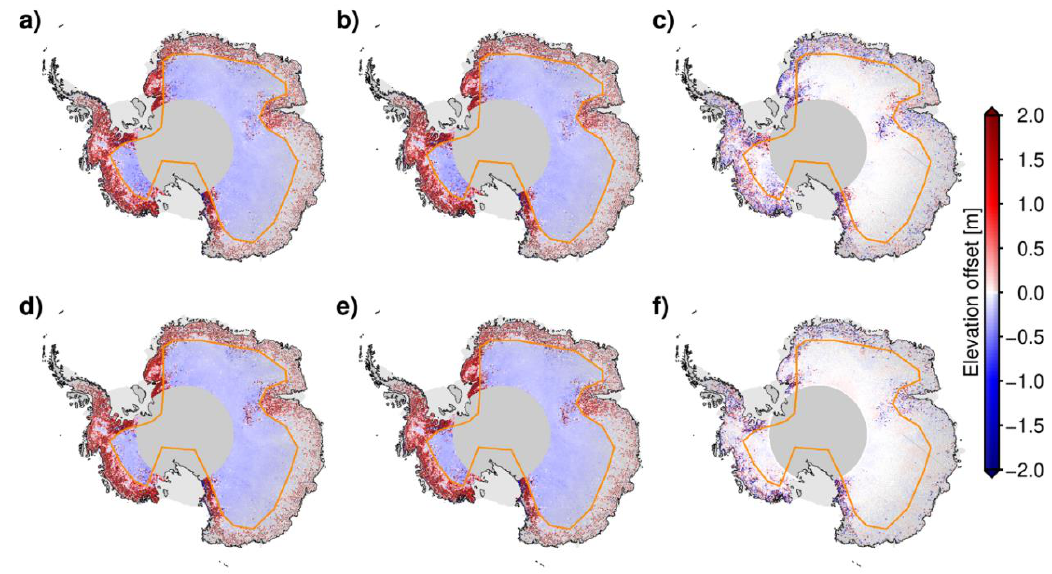
Figure 1. Maps of the total intermission biases between CryoSat-2 ascending tracks and Envisat ascending tracks (( a ), b C ), CryoSat-2 ascending tracks and Envisat descending tracks (( b ), b C ), CryoSat-2 descending tracks and Envisat ascending tracks (( d ), b C ), CryoSat-2 descending tracks and Envisat descending tracks (( e ), b C ) and the intramission ascending–descending (A–D) bias of Envisat (( c ), b C ) and CryoSat-2 (( f ), b E ) at the intersections of Envisat’s ascending tracks and descending tracks. The mode mask boundary between CryoSat-2’s LRM and SARIn modes [29] is shown in orange.